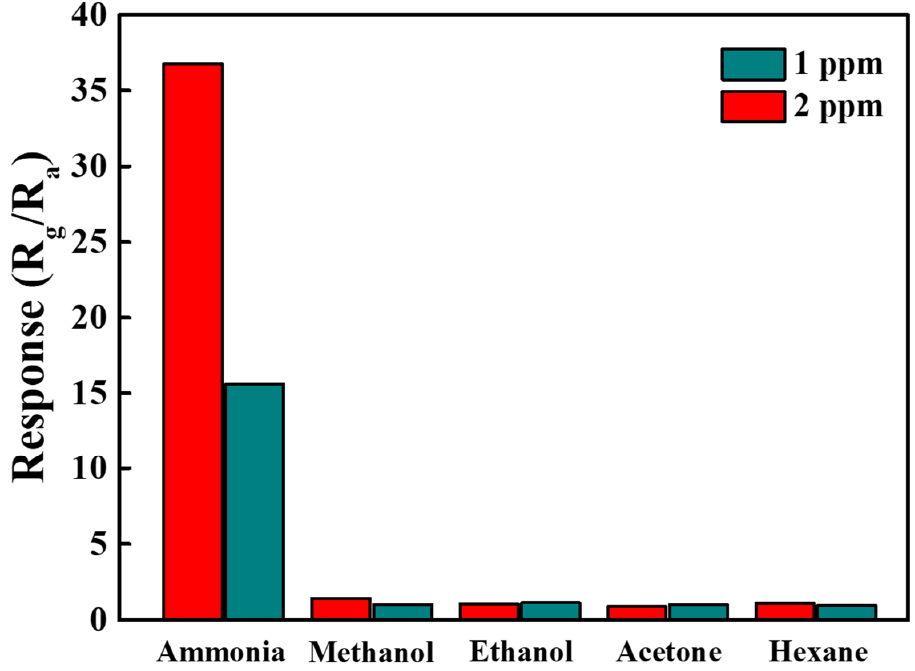
Figure 11. The selectivity of the PANI/GQD/hollow In 2 O 3 nanofiber film sensor tested at the concentrations of 1 and 2 ppm toward NH 3 , methanol, ethanol, and acetone. Table 2. Comparison of NH 3 -sensing performance of the PANI/N-GQD/hollow In 2 O 3 nanofiber sensor developed here with other sensors reported recently.